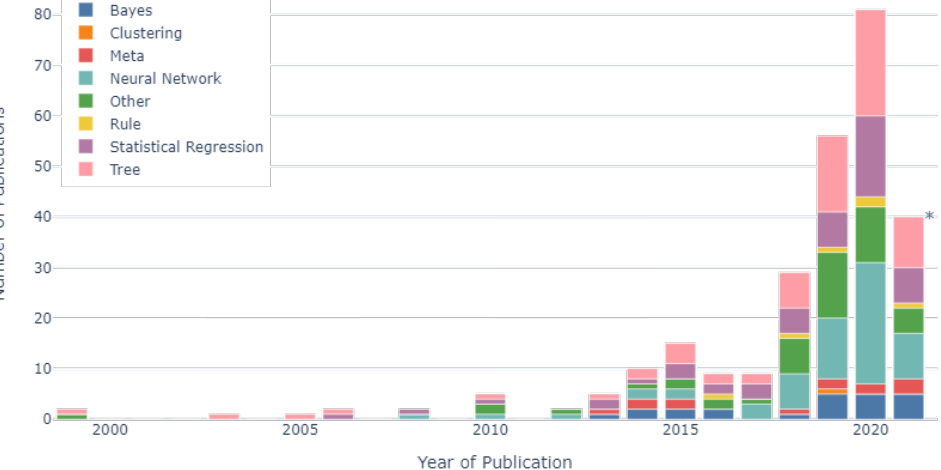
Figure 7. Number of publications per year labelled according to algorithm category (n = 269). * Data collected up to June 2021.